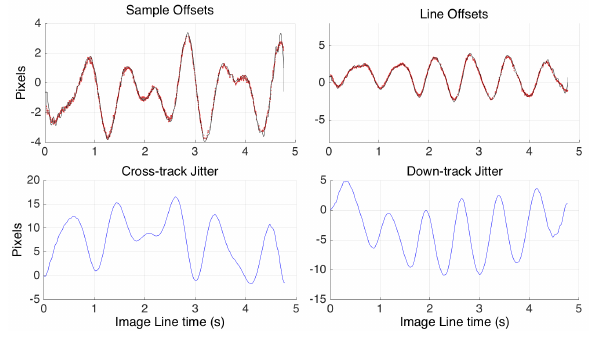
Figure 5. Output of ResolveJitter for PSP 007556 2010. Top row shows sample and line offset data for the RED4-5 pair (red) with predicted jitter from solution overplotted in black. Bottom row shows the modeled jitter